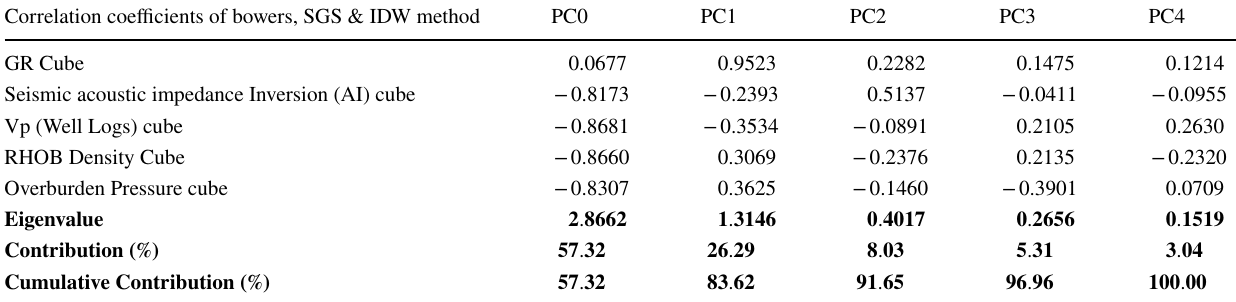
Table 4 Correlation coefficients (r) of the principal components analysis (PCA) of the final neural network model of effective pressure obtained from the initial models by Bowers, SGS, and IDW methods